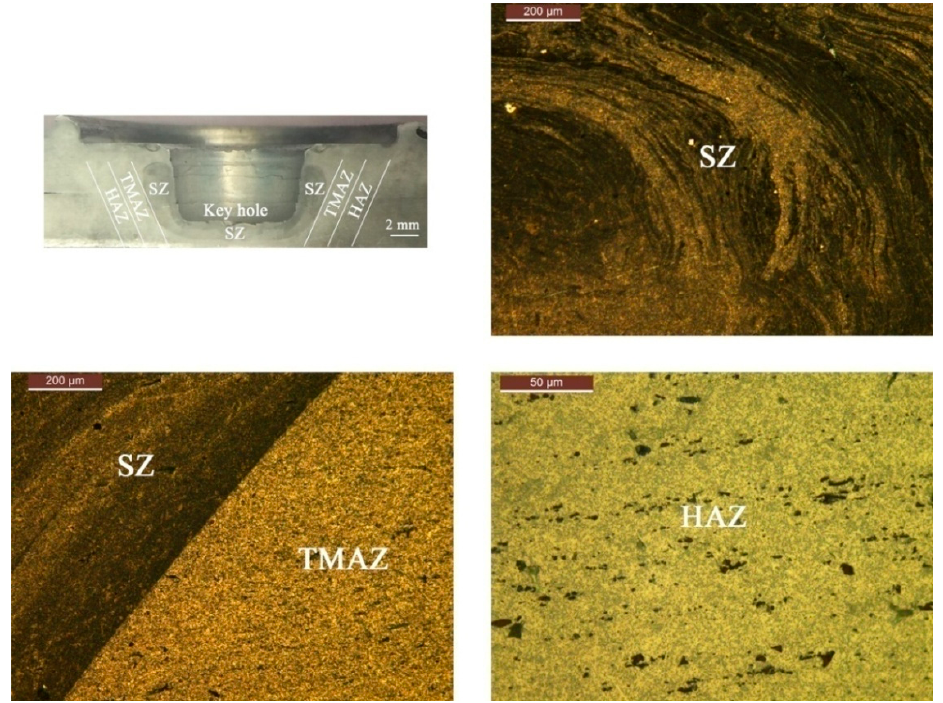
Figure 5. Optical micrographic views showing the various zones (SZ, TMAZ, and HAZ) of the AA5083/nano-SiC joints.